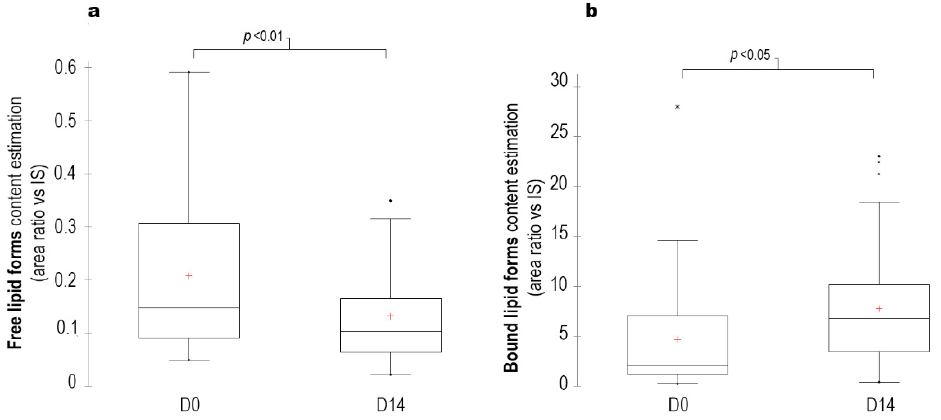
Figure 5. Kinetics of free lipid forms ( a ) and of bound lipid forms ( b ) concentrations in dogs with erythemato-ceruminous otitis externa that received the tested ear cleanser at different time points during the study (results are expressed as area ratio vs internal standard (IS)). Explanation for box and whisker plots: the top of the box represents the third quartile, the red cross (+) is the mean, the horizontal bar in the box is the median, the bottom of the box is the first quartile and the upper and lower whiskers represent minimum and maximum scores. Dots were considered as outliers.